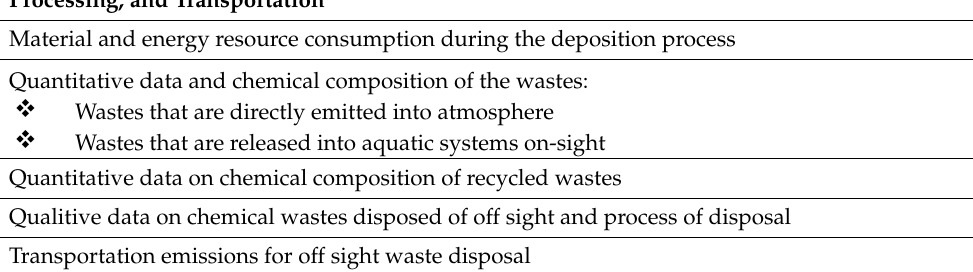
Table 4. Examples of the type of data required for the